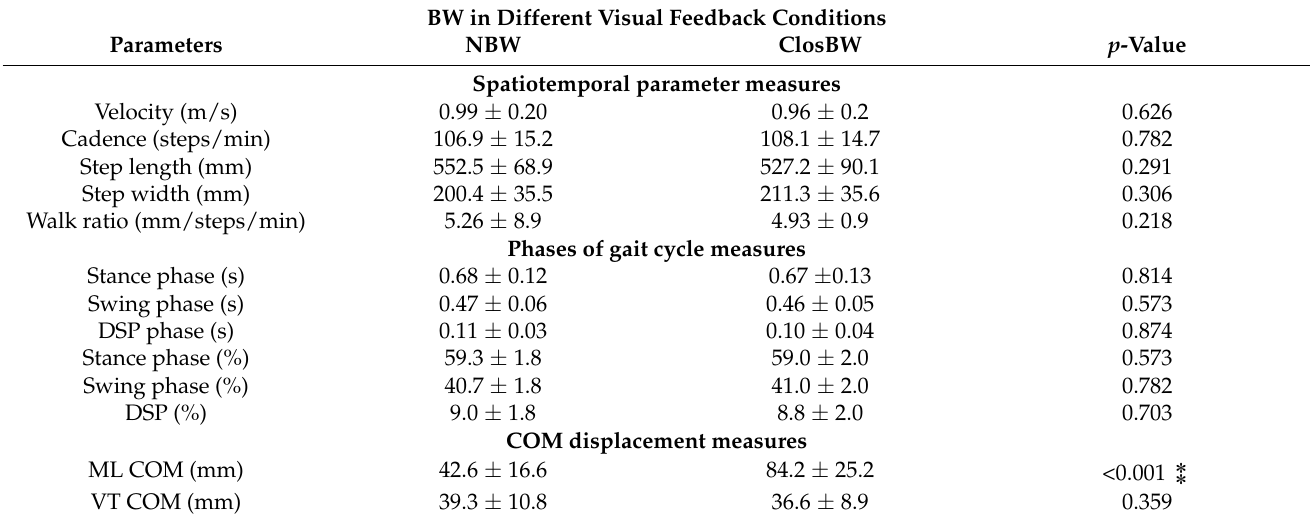
Table 4. Effect of visual feedback during backward walking.